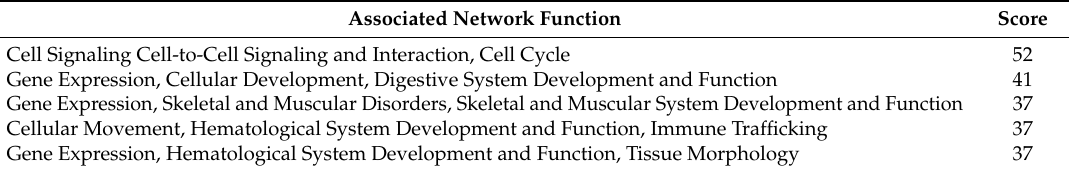
Table 9. Top gene networks associated with lactobacilli treatment—IPA analysis. Associated Network Function Score Cell Signaling Cell-to-Cell Signaling and Interaction, Cell Cycle 52 Gene Expression, Cellular Development, Digestive System Development and Function 41 Gene Expression, Skeletal and Muscular Disorders, Skeletal and Muscular System Development and Function 37 Cellular Movement, Hematological System Development and Function, Immune Trafficking 37 Gene Expression, Hematological System Development and Function, Tissue Morphology